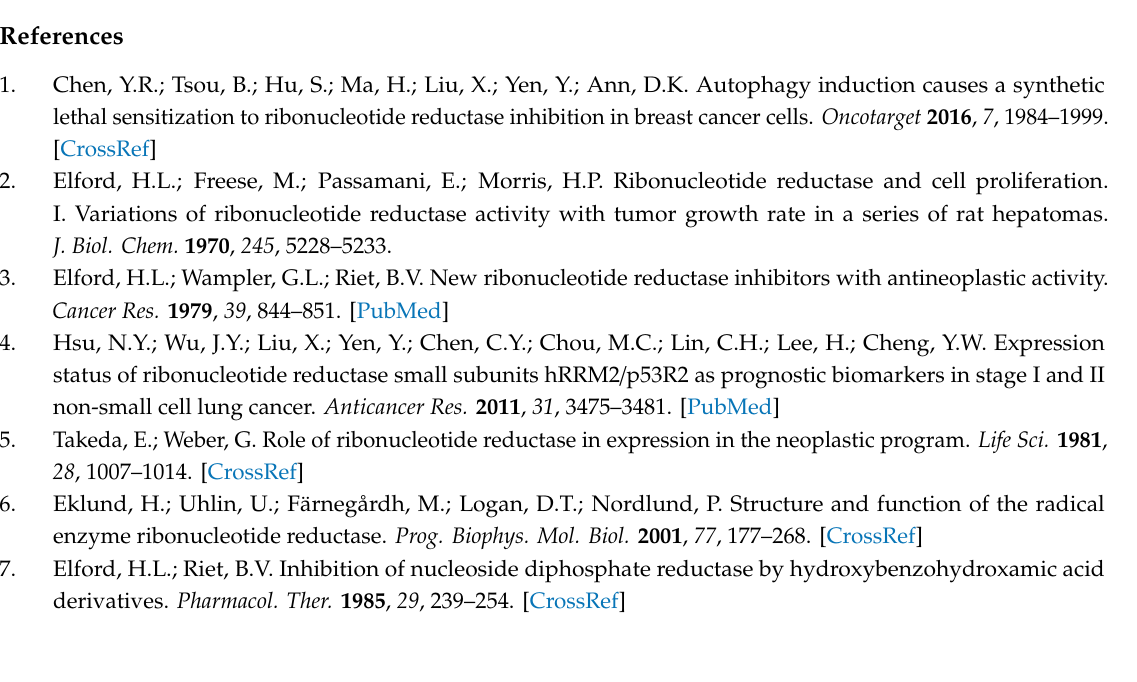
Figure S1: Didox reduced cell viability in the HCC cell line in time and a dose-dependent manner. Table S1: Calculation of IC 50 , Figure S2: Treatment with an equimolar concentration of iron rescued DFO- and DFP- but not HU-induced cell